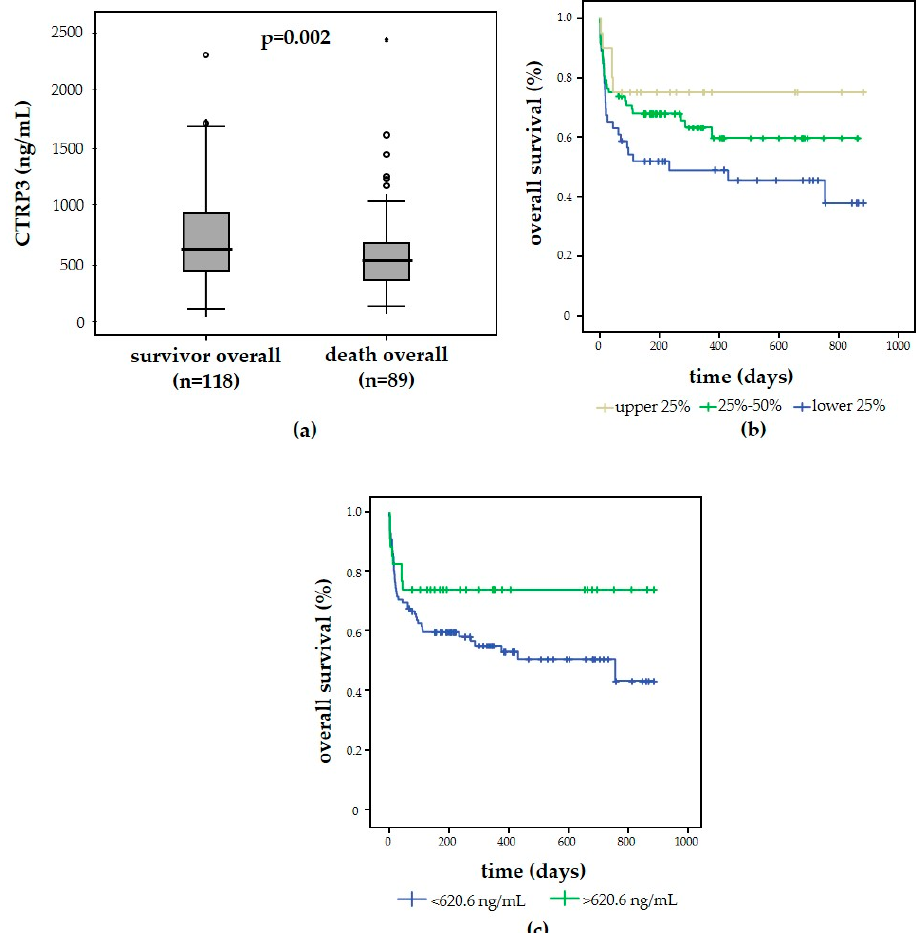
Figure 3. CTRP3 is a biomarker for mortality in critically ill patients. Patients that subsequently died displayed significantly lower CTRP3 levels at ICU admission compared to patients that survived in the long-term follow-up ( a ). High vs. low CTRP3 plasma concentrations discriminated survival of the critically ill patients, as displayed by Kaplan–Meier survival curve analysis for CTRP3 separated into quartiles ( b ). Low CTRP plasma concentrations at ICU admission (optimal cut-off: 620.6 ng/mL) predicted the overall mortality in critically ill patients ( c ).